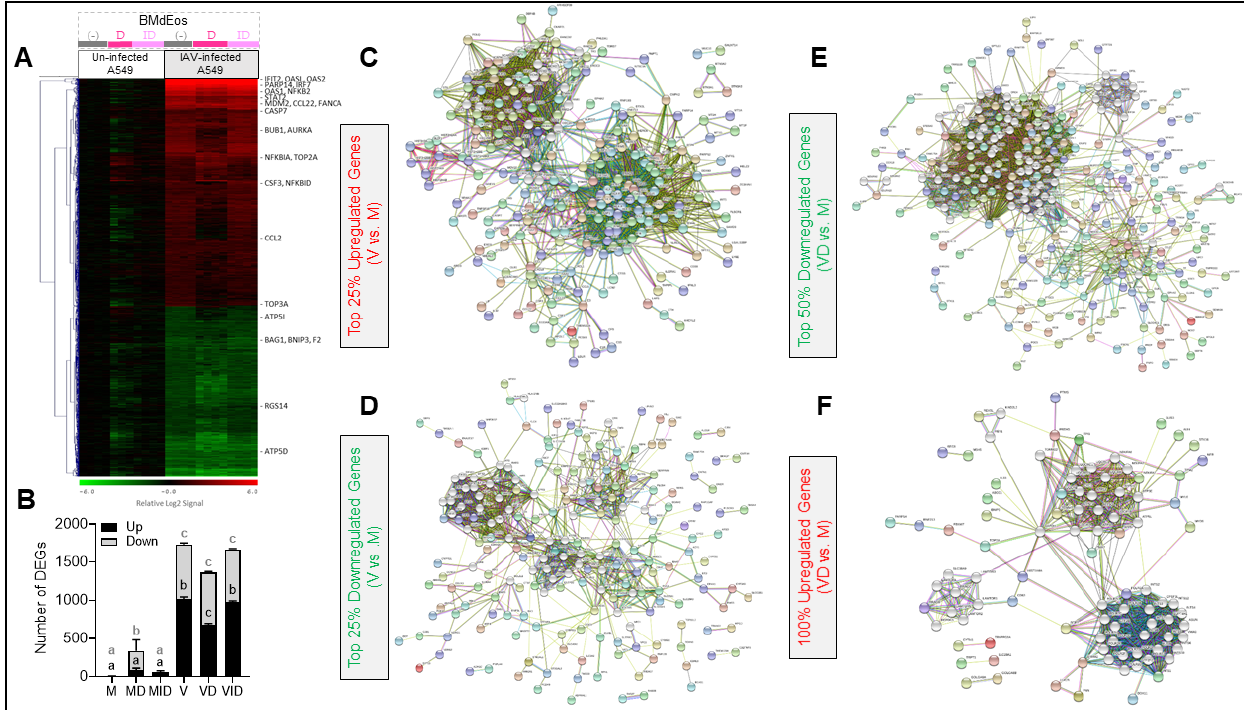
Figure 5. Eosinophils affect the epithelial transcriptome during influenza virus infection. ( A ) Microarray analysis of the A549 cell transcriptome during mock or influenza virus (IAV) infection when in direct (d) or indirect (id) contact with bone marrow derived eosinophils (BMdEos). Heat map contains log 2 signal values for 1969 individual samples normalized to the row mean log 2 signal value for samples M1-M4 (Mock-infected, no BMdEos). Dendrogram (left side) shows hierarchical clustering of genes by complete linkage based on euclidean distance. ( B ) The number of differentially expressed genes (DEGs) in each group relative to the average expression in the M group shown as a stacked bar representing the mean and standard deviation. Up- and down-regulated genes were compared across the groups by 2-way ANOVA with Tukey’s multiple comparisons test where letters above bars represent p < 0.05 when different. Protein interaction networks generated by STRINGdb are shown for: ( C ) Top 25% of upregulated genes (281 DEGs) between mock-infected and IAV-infected epithelial cells with no BMdEos exposure; network required an edge confidence score ≥ 0.700 and contains an additional 20 s shell nodes (white). ( D ) Top 25% of downregulated genes (212 DEGs) between mock-infected and IAV-infected epithelial cells with no BMdEos exposure; network required an edge confidence score ≥ 0.400 and contains an additional 30 s shell nodes (white). ( E ) Top 50% of downregulated genes (267 DEGs) between mock-infected and IAV-infected epithelial cells with direct BMdEos exposure; network required an edge confidence score ≥ 0.400 and contains an additional 55 s shell nodes (white). ( F ) All upregulated genes (91 DEGs) between mock-infected and IAV-infected epithelial cells with direct BMdEos exposure; network required an edge confidence score ≥ 0.400 and contains an additional 65 s shell nodes (white). For closer inspection, individual PNG files of the protein interaction networks shown in C-F are provided in Supplementary Materials as Figures S1C, S2D, S3E, and S4F. Please note that gene expression data and pathway analysis results of these data